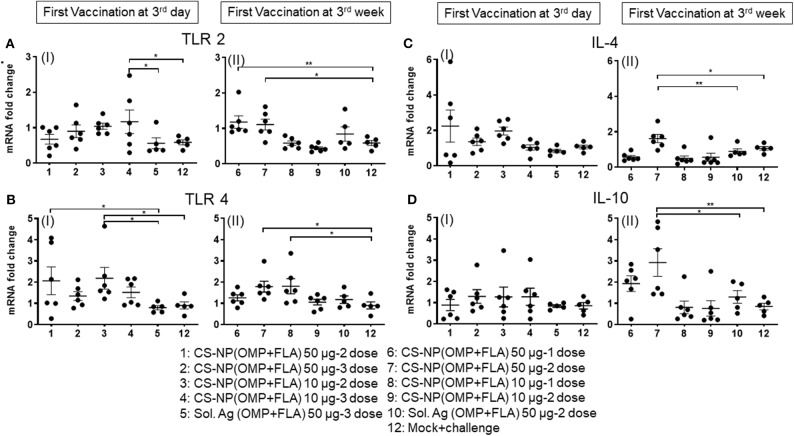
TLR and cytokine gene expression in vaccinated and SE challenge birds. Cecal tonsils harvested on the day of necropsy were analyzed for the expression of TLRs and cytokine mRNA in CS-NP(OMP+FLA) vaccinated birds by qRT-PCR. (A) TLR 2 (I and II), (B) TLR 4 (I and II), (C) IL-4 (I and II) and (D) IL-10 (I and II). Fold-change in gene expression was calculated after correcting for β-actin mRNA value and normalizing to mRNA content of mock group. Data were presented as mean ± SEM of 6 or 5 birds. Significant difference between the indicated two groups were determined by one-way ANOVA followed by Tukey post-hoc test. *P < 0.05, **P < 0.01.